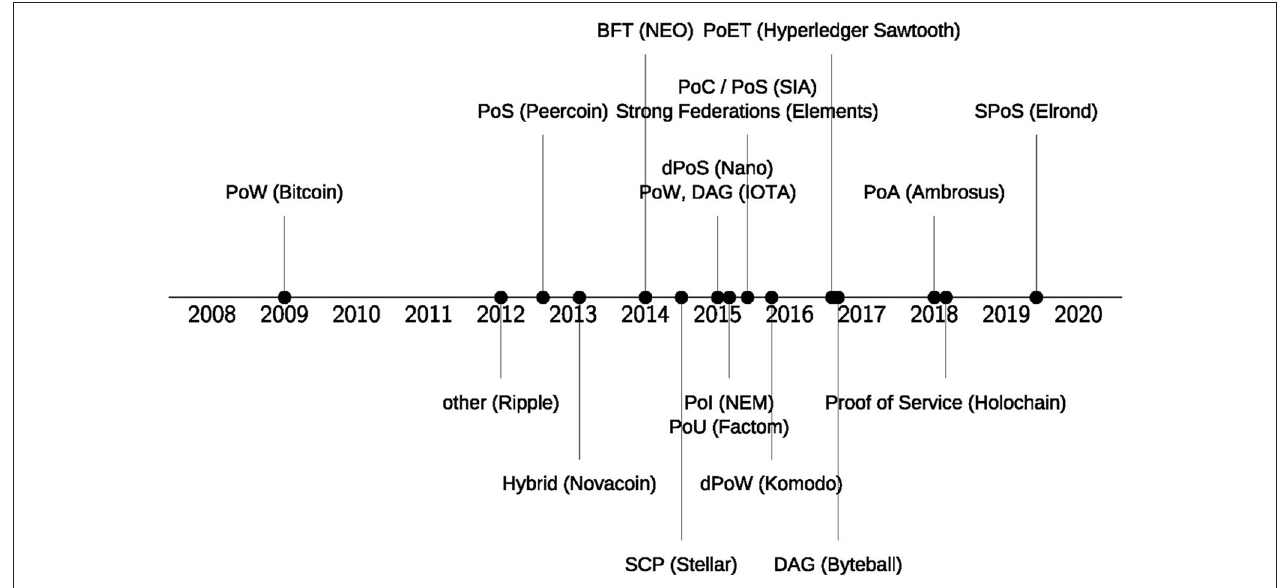
FIGURE 7 | The emergence of new consensus layouts over